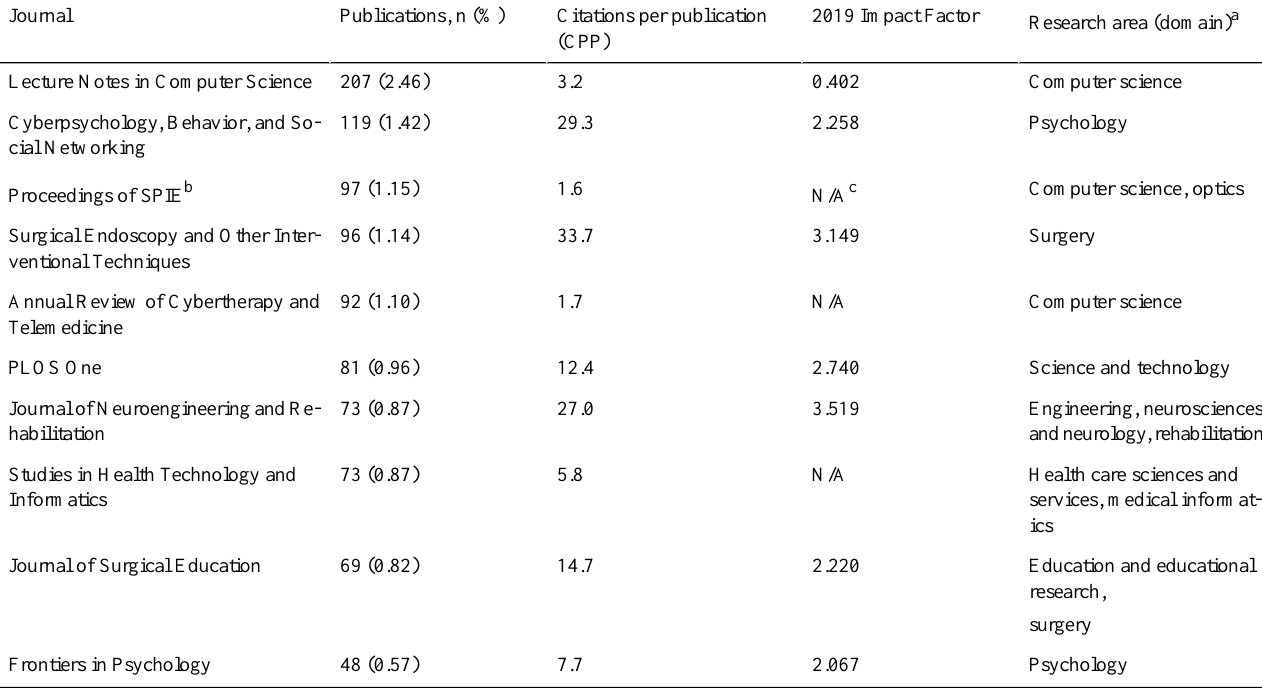
Table 4. The 10 most productive journals of virtual reality research in medicine (8399